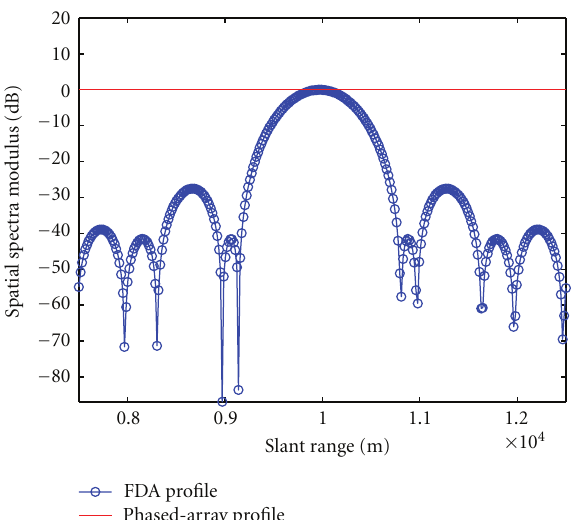
Figure 8: The comparative angle profiles at the target’s angle.